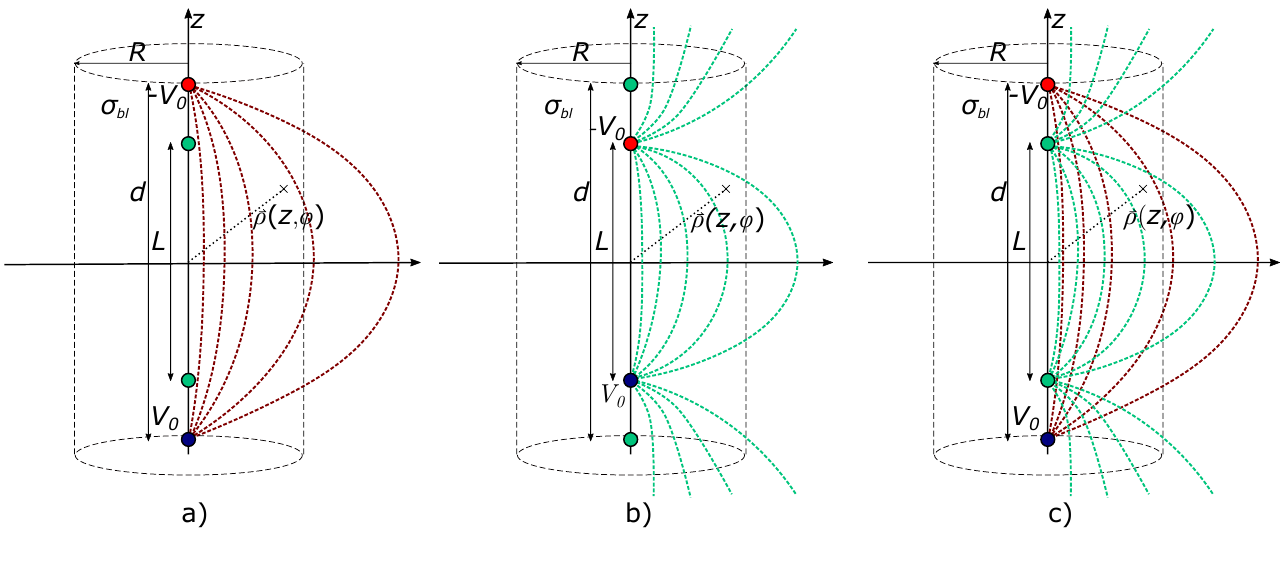
Figure 3: Left: electric field distribution of the injection at the outer electrodes with distance d . Middle: electric field distribution of the injection at the inner electrodes with distance L . Right: electric field distribution considering both the injection and the measurement field according to lead field